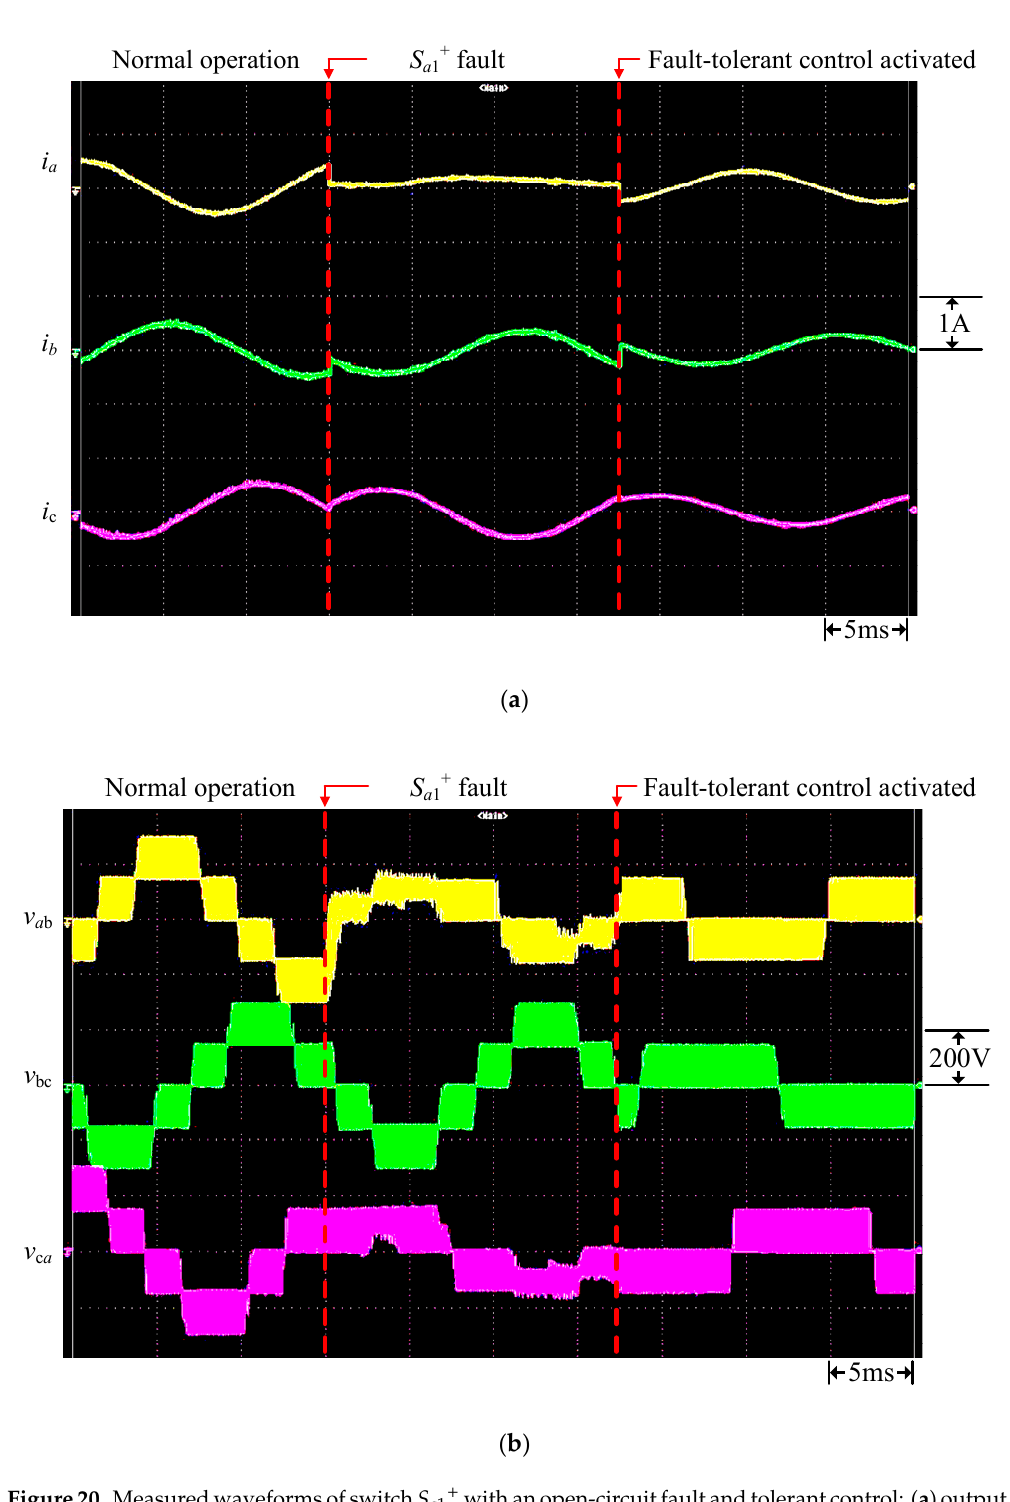
Figure 20. Measured waveforms of switch S a1+ with an open-circuit fault and tolerant control: ( a ) output line current; ( b ) output line voltage.